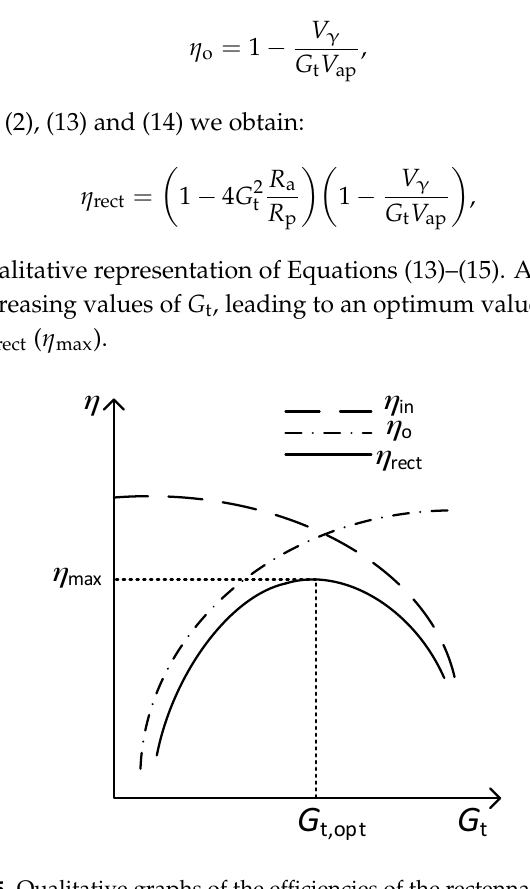
Figure 5. Qualitative graphs of the efficiencies of the rectenna versus G t .